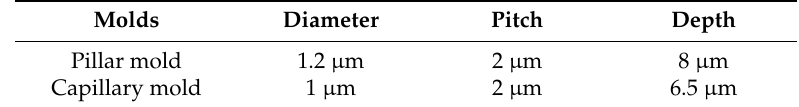
Table 6. Glass reflow conditions.